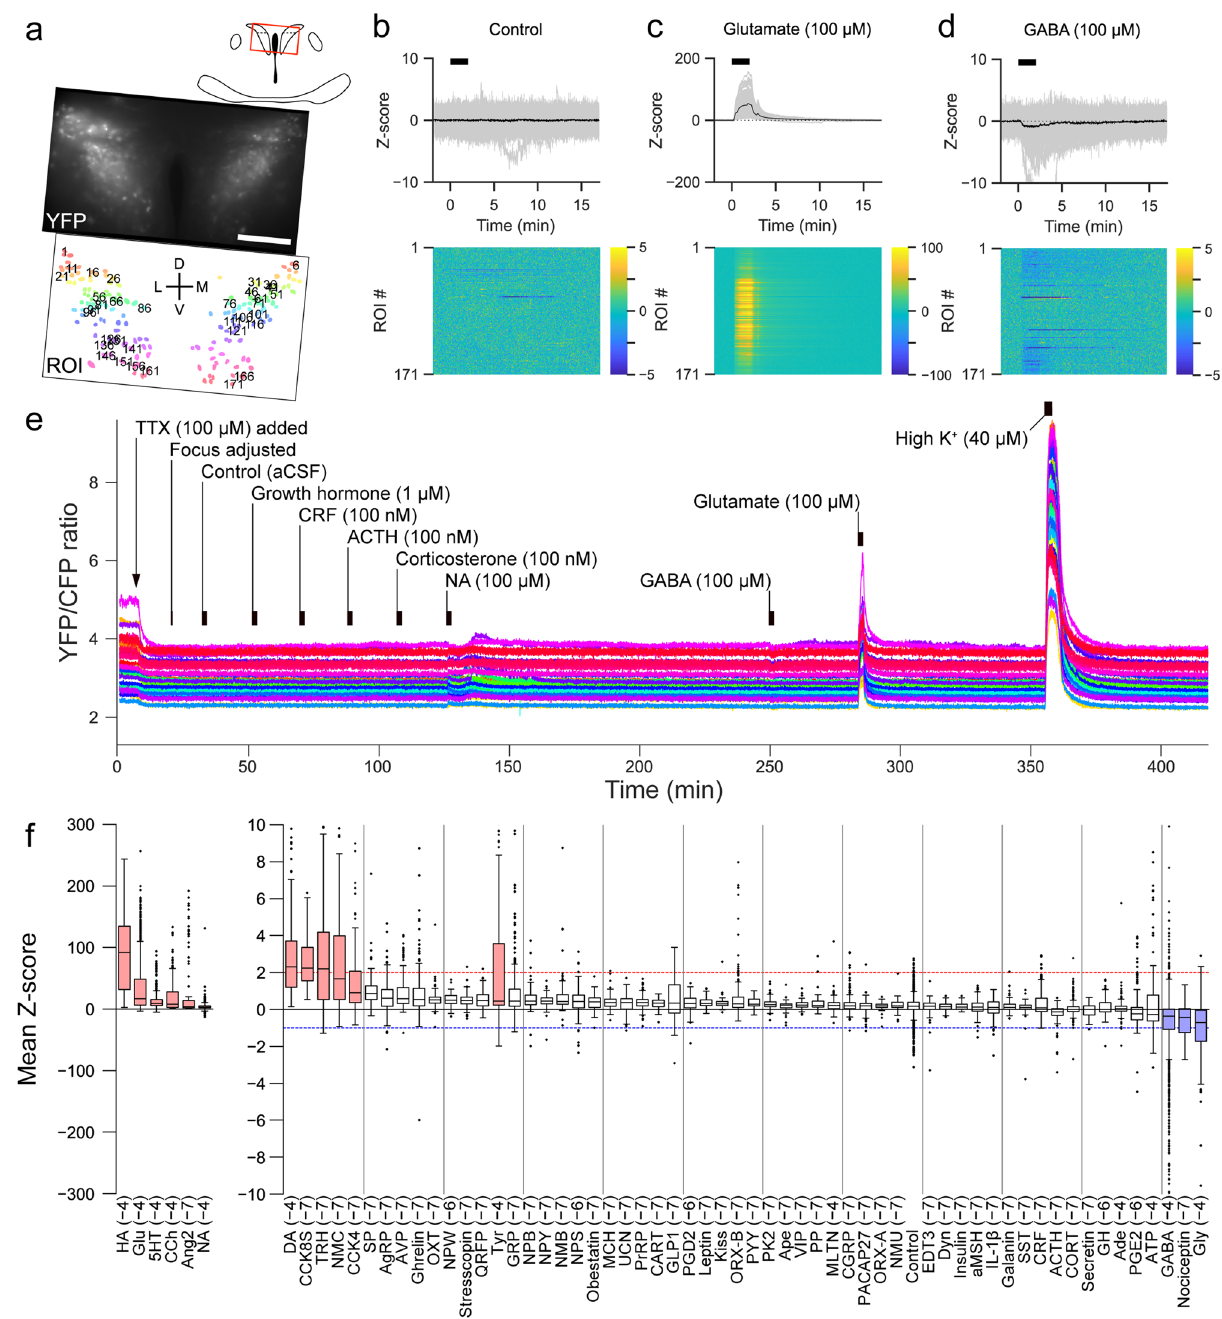
Figure 2. Screen for substances affecting intracellular calcium concentration in PVN-CRF neurons. ( a ) YFP signal at baseline (upper) and in the regions of interest (ROIs, lower) of a representative brain slice. Numbers superimposed over the ROIs align with the dorsoventral axis (from dorsal to ventral). D dorsal, V ventral, L lateral, M medial; scale bar: 100 μm. ( b – d ) Z-scores of the YFP/CFP ratio recorded from the brain slices shown in ( a ). Upper graphs show traces of individual ROIs (gray) and mean values (black). Black bars indicate the application timing (2 min) of each substance indicated above the graph ( b , control; c , glutamate; d , GABA). Heat maps show the Z-scores of individual ROIs indicated by the color bars at right. ( e ) Entire sequence of the YFP/CFP ratio for 1 in every 5 ROIs (35 total ROIs, shown as numbers in a ) of the brain shown in ( a )–( d ). ( f ) Box plots of the calcium signal changes induced by the substances indicated below. In the box plots, the top and bottom of each box indicate the 75% and 25% points, respectively. The line inside the box indicates the median value. Upper and lower ends of the whiskers indicate the points no more than the IQR (interquartile range) × 1.5 from the edge of the box, where IQR = (the value of the 75% point) – (the value of the 25% point). Dots indicate outliers which are data points beyond the whiskers. Abbreviations are listed in Table 1. The compounds are listed in the order of median value. Values in parentheses indicate the Log10 concentration of the substances in mol/L. Red and blue lines indicate where the mean Z-score = 2 and − 1, respectively. Boxes filled in red or blue indicate the substances which increased or decreased intracellular calcium concentrations,